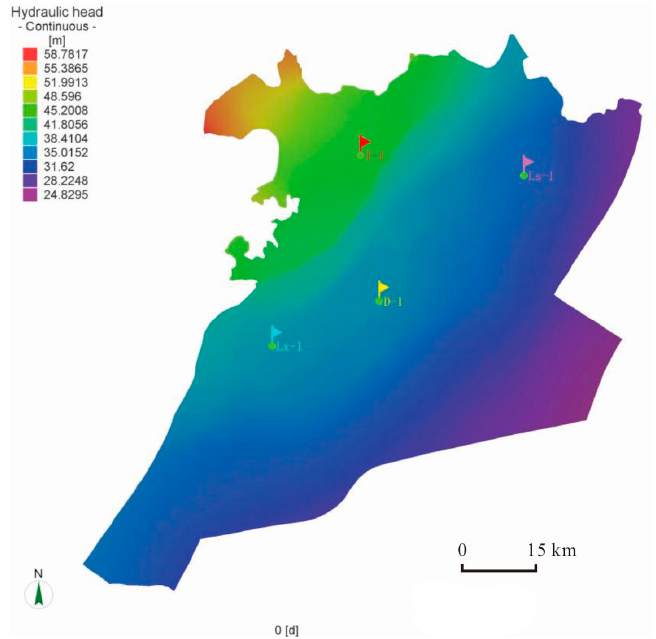
Figure 10. Distribution of hydraulic heads of groundwater at the beginning of the simulated period.